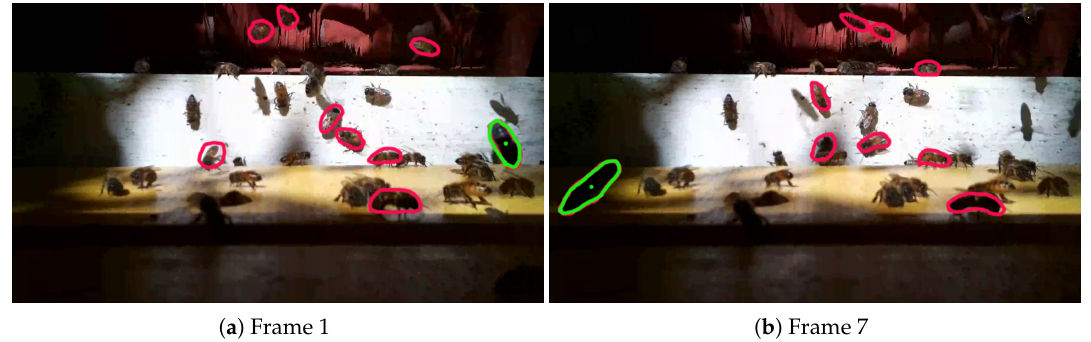
Figure 9. The first and last frames (Frames 1 and 7, respectively) from a sequence of seven consecutive frames taken from a high bee traffic video; the entire seven-frame sequence is given in Table